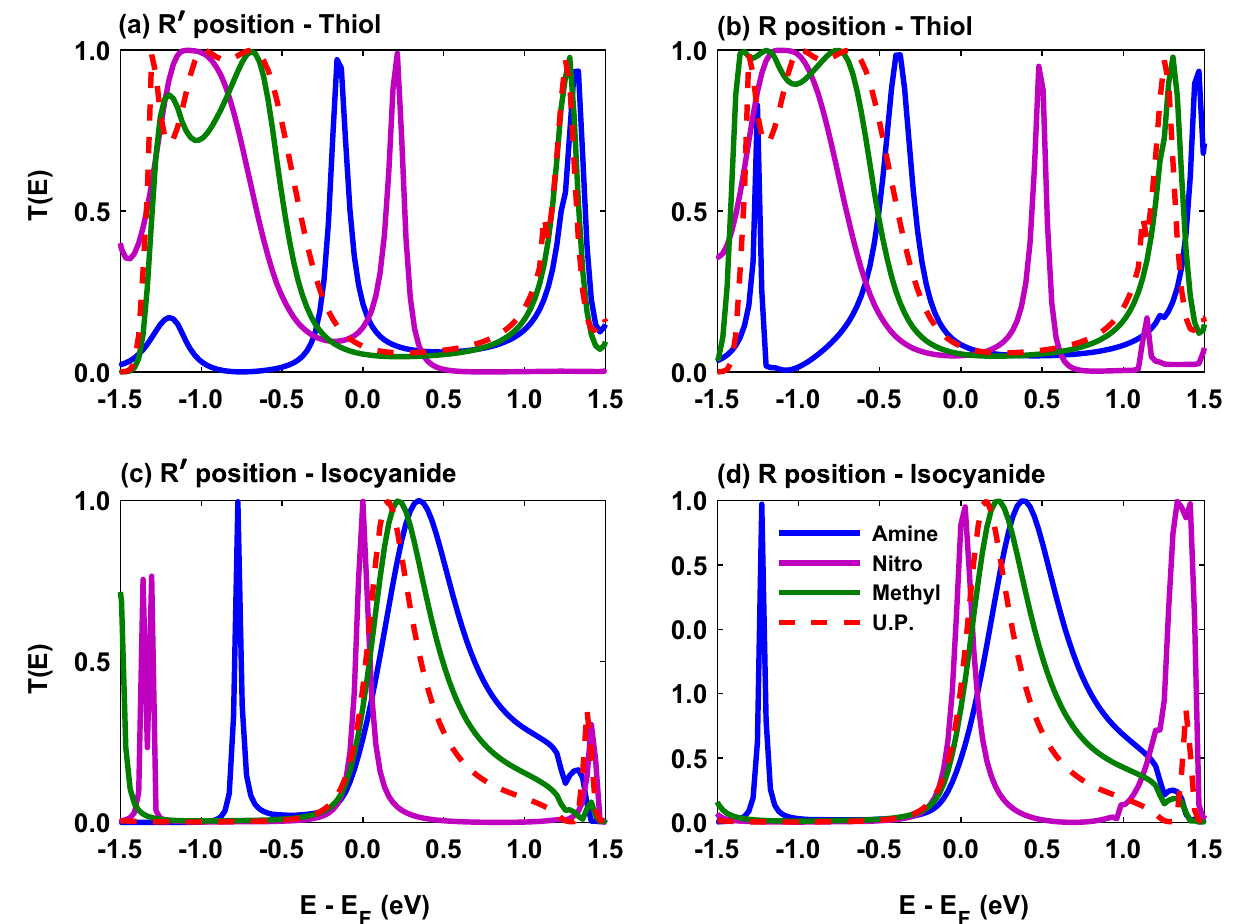
Figure 6. The transmission coefficient of the Au-anthracene-Au junction versus energy when the thiol anchoring group mediates molecule-electrode contact in the presence of amine (blue), nitro (magenta) or methyl (green) as the side group in ( a ) R ′ and ( b ) R positions. The transmission coefficient of the isocyanide- terminated junction with amine (blue), nitro (magenta) or methyl (green) side group in ( c ) R ′ and ( d ) R positions. Also, the transmission coefficient of the unperturbed (U.P.; red) system in the absence of side groups from Fig. 2 is redrawn to make the comparison